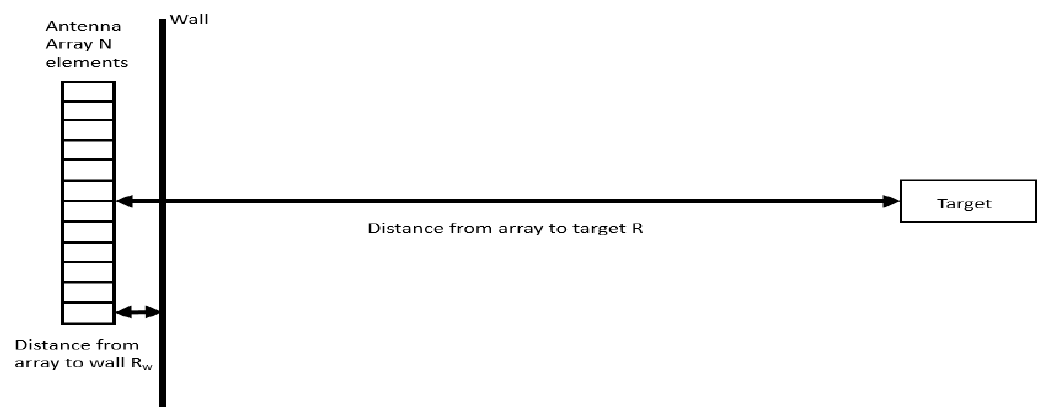
Figure 2. Experimental layout for collecting target returns.